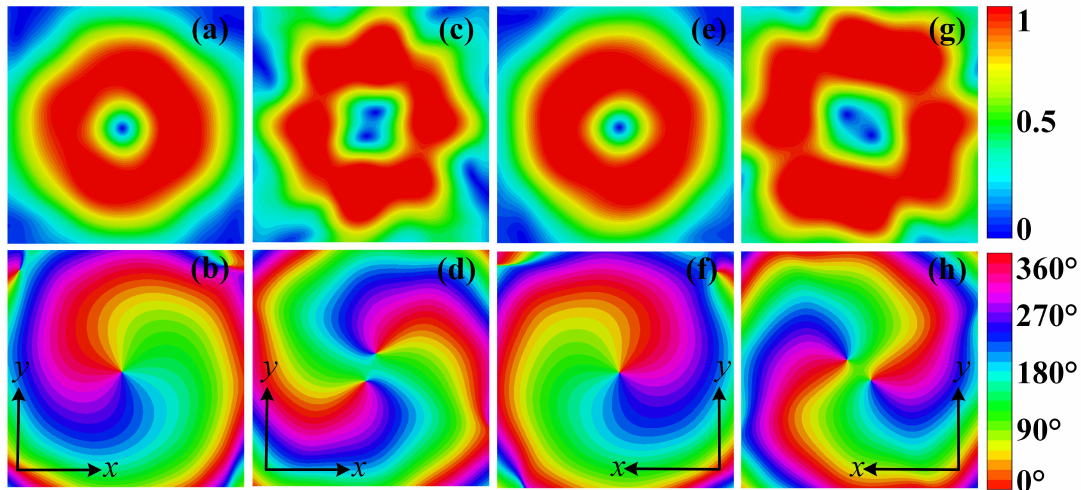
Figure 7. Simulated cross-polarized electric field distributions of the transmitted OAM carrying beams at a transverse plane 250 mm away from the metasurface: ( a ) Amplitude and ( b ) phase distributions for OAM order of l = + 1. ( c ) Amplitude and ( d ) phase distributions for OAM order of l = + 2. ( e ) Amplitude and ( f ) phase distributions for OAM order of l = − 1. ( g ) Amplitude and ( h ) phase distributions for OAM order of l = − 2.